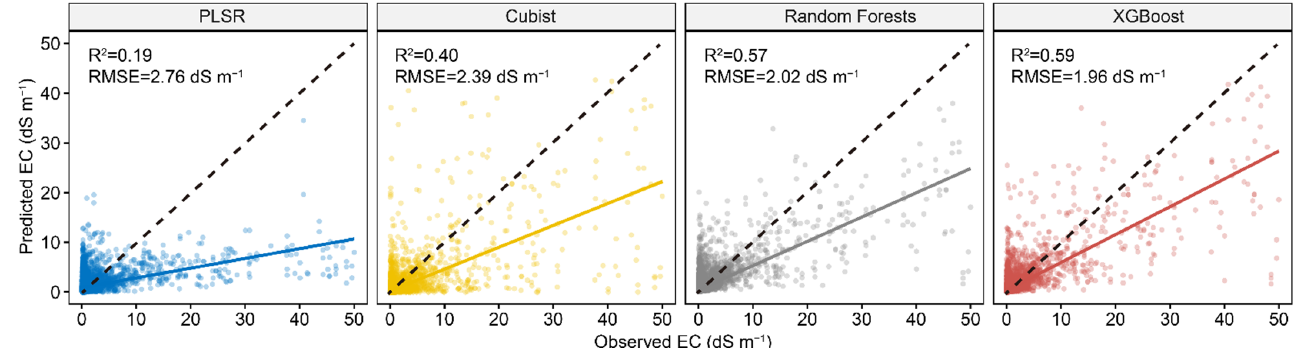
Figure 4. Scatter plots of four spectral predictive models using first 30 PCs of Vis-NIR spectra. The solid line is a fitted line for each model, whereas the dashed line is the 1:1 line.